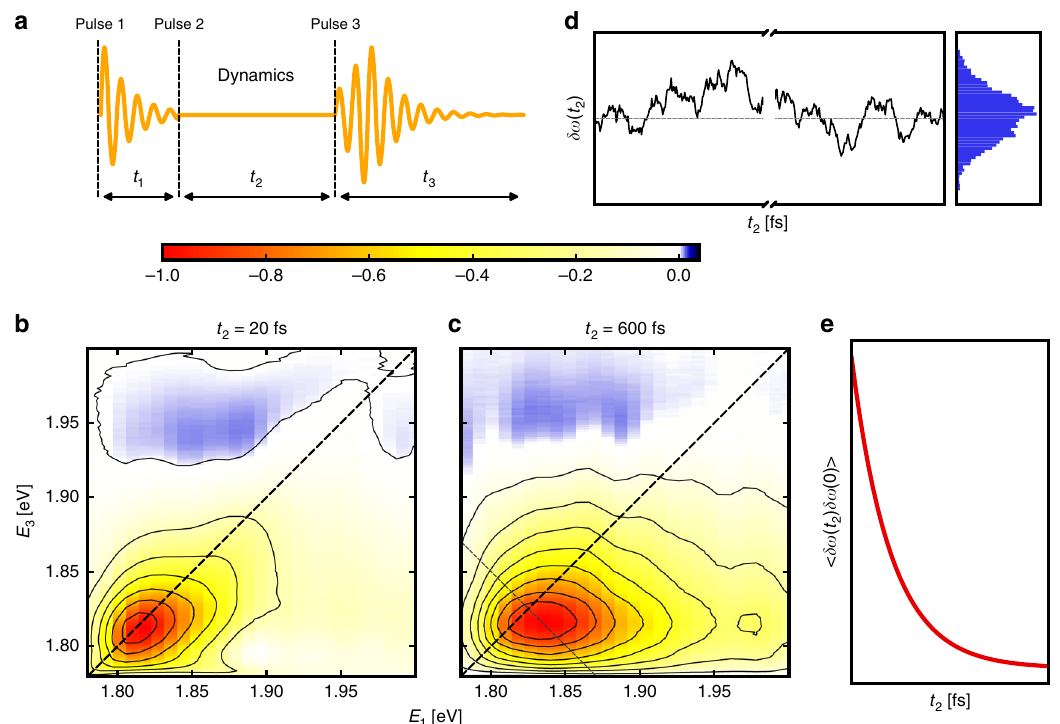
Fig. 2 2DES measurements on the CsPbI 3 nanocrystals and basic concepts of spectral diffusion. a Typical pulse sequence in a 2D experiment. Pulse 1 creates a coherent superposition of quantum states, which dephases during t 1 . Pulse 2 transforms the coherence into a population state, which undergoes dynamics. Pulse 3 creates a coherence again, and the emitted fi eld is detected. b , c Exemplary 2D spectra of an ensemble of CsPbI 3 nanocrystals, for t 2 = 20 fs ( b ) and t 2 = 600 fs ( c ). d The rounding up of the peak in the 2D spectrum as t 2 increases can be described by the process of spectral diffusion. Here a simulated Ornstein – Uhlenbeck trajectory illustrates the modulation of the bandgap by correlated fl uctuations. The histogram shows the distribution of frequencies, which approaches a Gaussian upon memory loss of the initial frequency. e The frequency – frequency correlation function describes the loss of correlation as a function of t